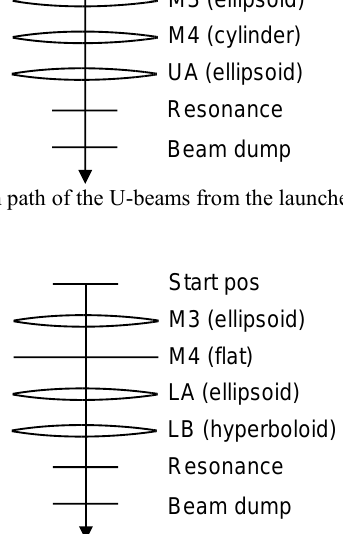
Fig. 3. Beam path of the L-beams from the launcher to